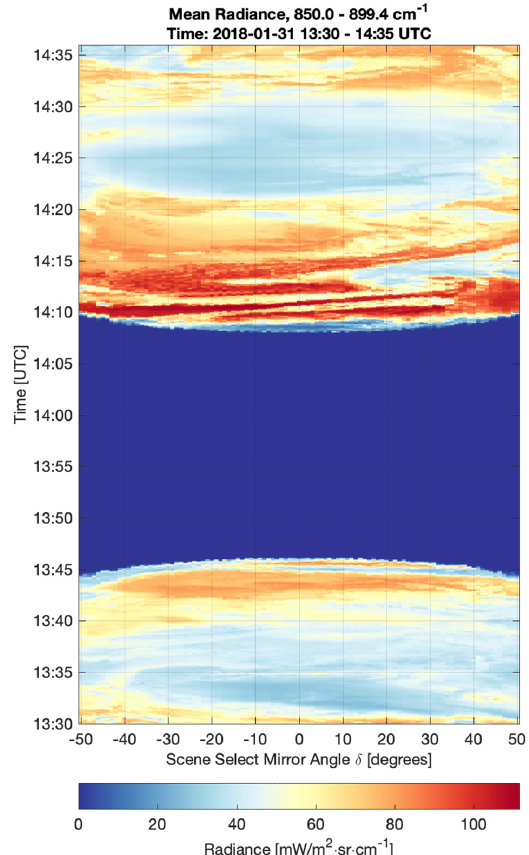
Figure 9. NOAA-20 CrIS radiance image. The CrIS calibrated radiance has been averaged from 850 to 900 cm − 1 and plotted versus time (y-axis) and scene select mirror angle (x-axis). All cross-track fields of regard are viewing deep space between roughly 13:46 and 14:08 UTC.